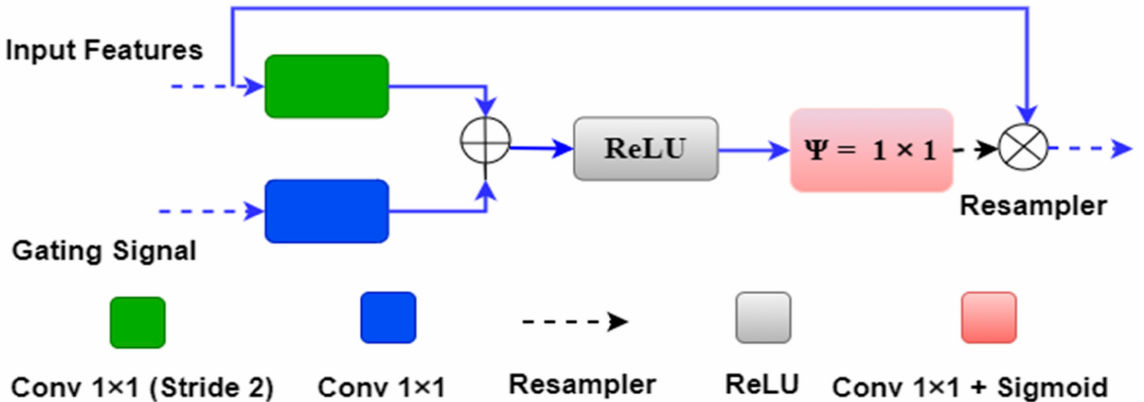
Figure 5. Attention block with input features, gating signals and weighted